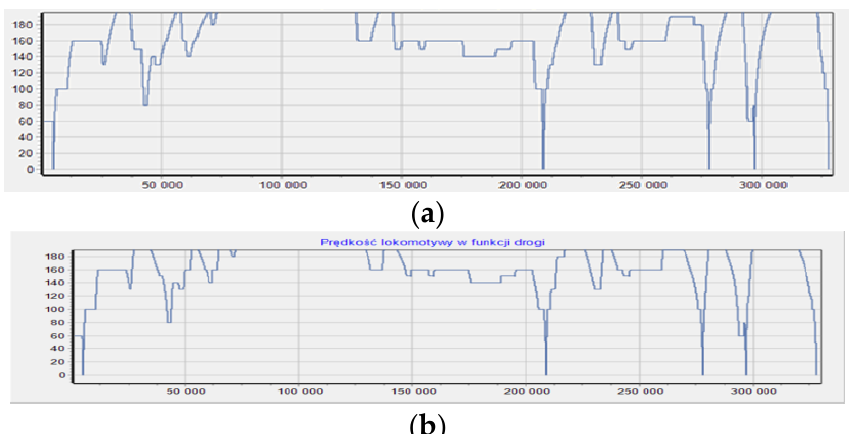
Figure 9. Trains speed profile on TI line ( a ) direction W-Gd and ( b ) direction Gd-W. Source: developed by the authors-results of simulations.